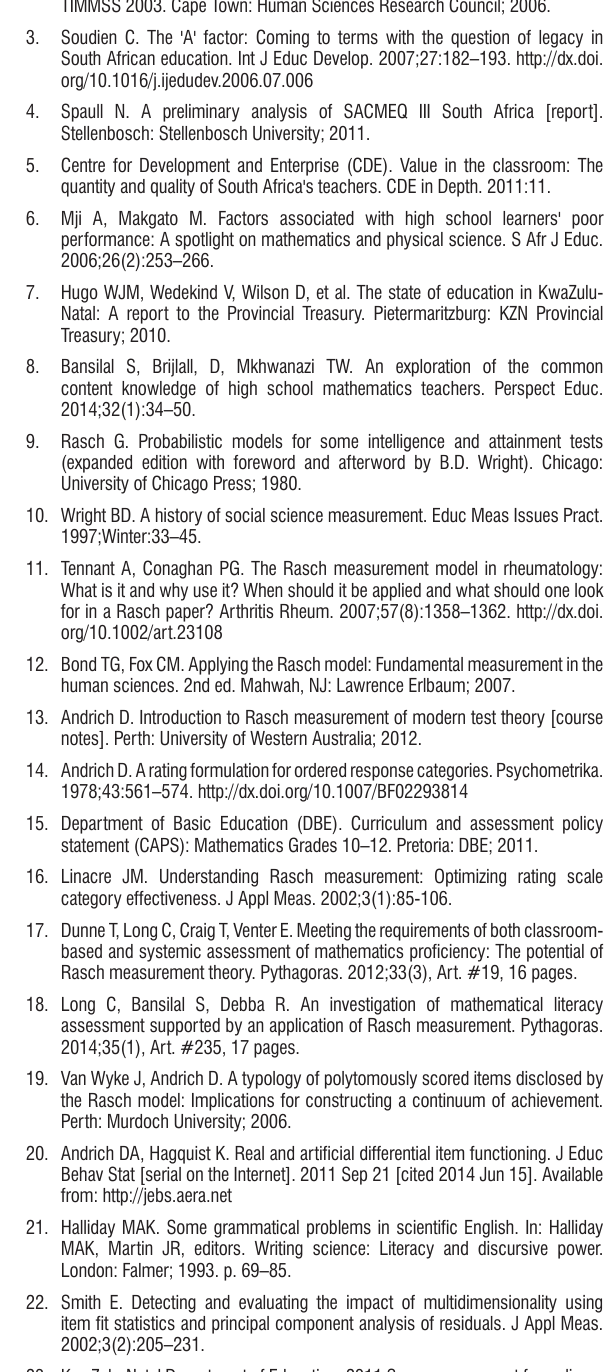
Figure 10: Person–item map approximating person proficiency and item difficulty on a common scale. Items classified at Level 1 are indicated in ordinary font, Level 2 in italics; Level 3 in bold and Level 4 in bold